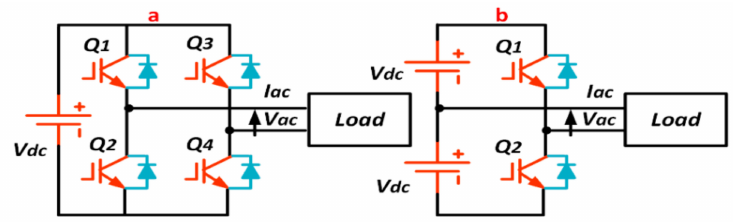
Figure 13. Comparison of ( a ) full-bridge topology and ( b ) half-bridge technique [69].